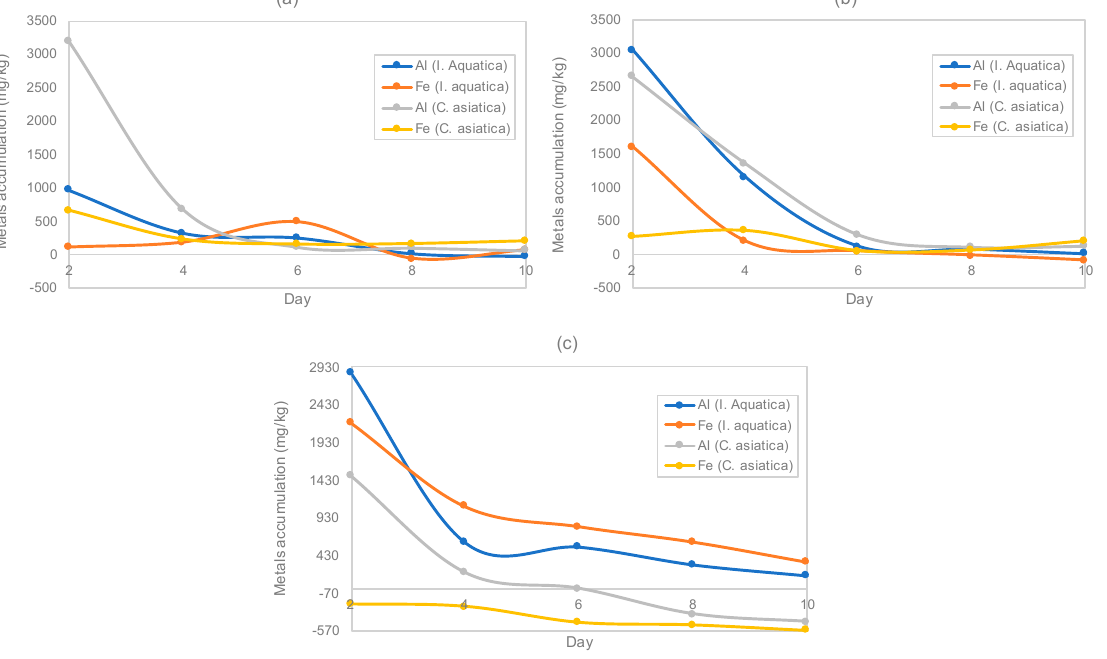
Figure 4. Accumulation of Al and Fe in the: ( a ) leaf; ( b ) stem, and ( c ) root sections by Ipomoea aquatica and Centella asiatica .